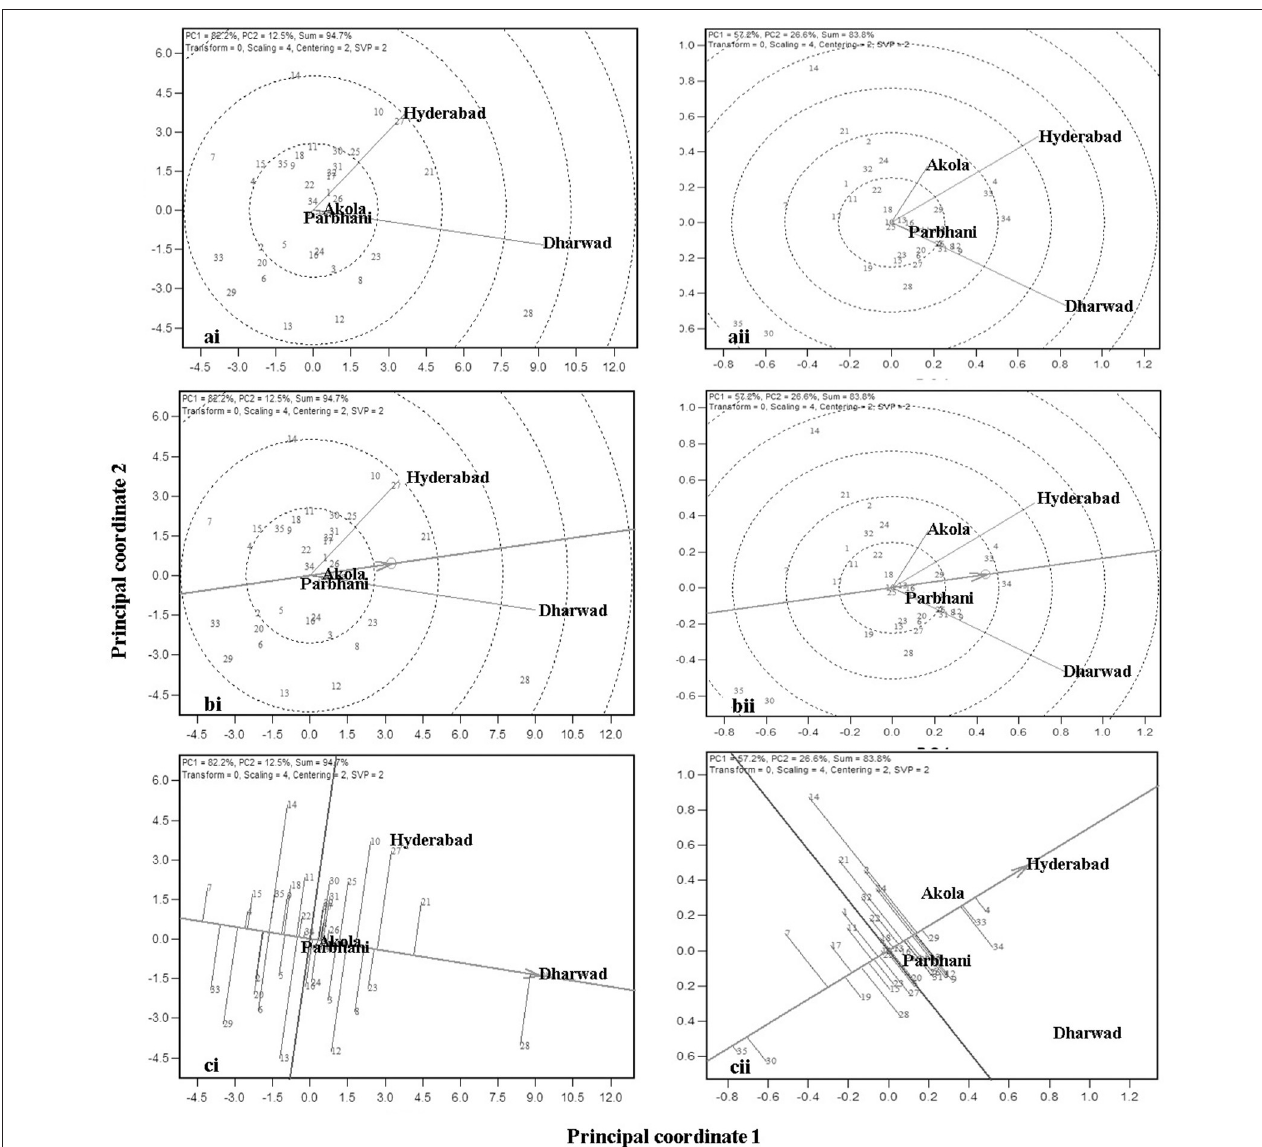
FIGURE 5 | GGE biplot showing relation among the four test locations with respect to GY ( a i) and grain mold score ( a ii); ranking of locations based on the discriminating ability and representativeness for GY ( b i) and grain mold score ( b ii); and Ranking of 35 sorghum genotypes based on their performance in the near ideal location, for GY ( c i) and grain mold score ( c